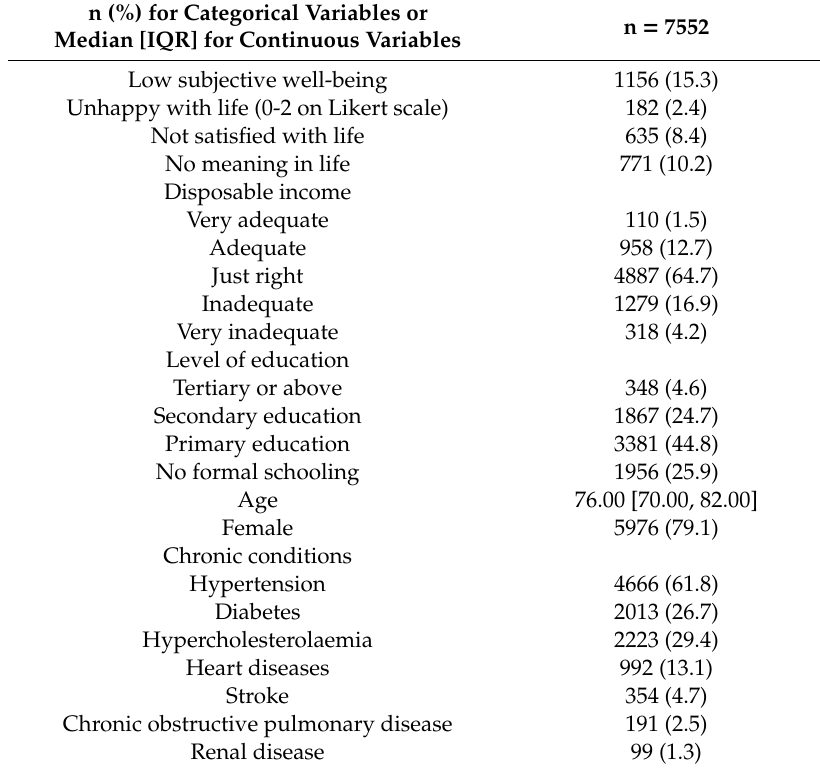
Table 1. Baseline characteristics of the cohort participants of the Jockey Club Community eHealth Care